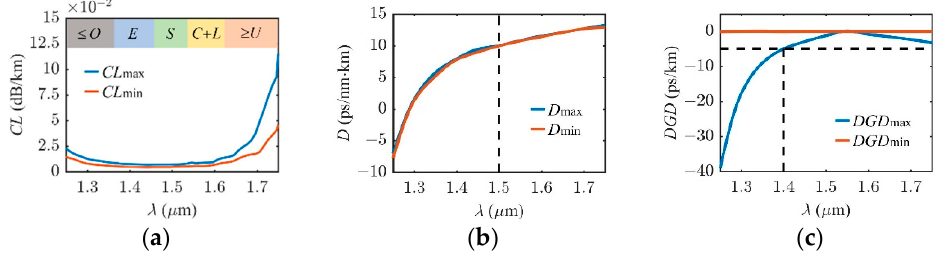
Figure 13. ( a ) CL of the change in TCS-ARF with λ . ( b ) D of the change in TCS-ARF with λ . ( c ) DGD of the change in TCS-ARF with λ .